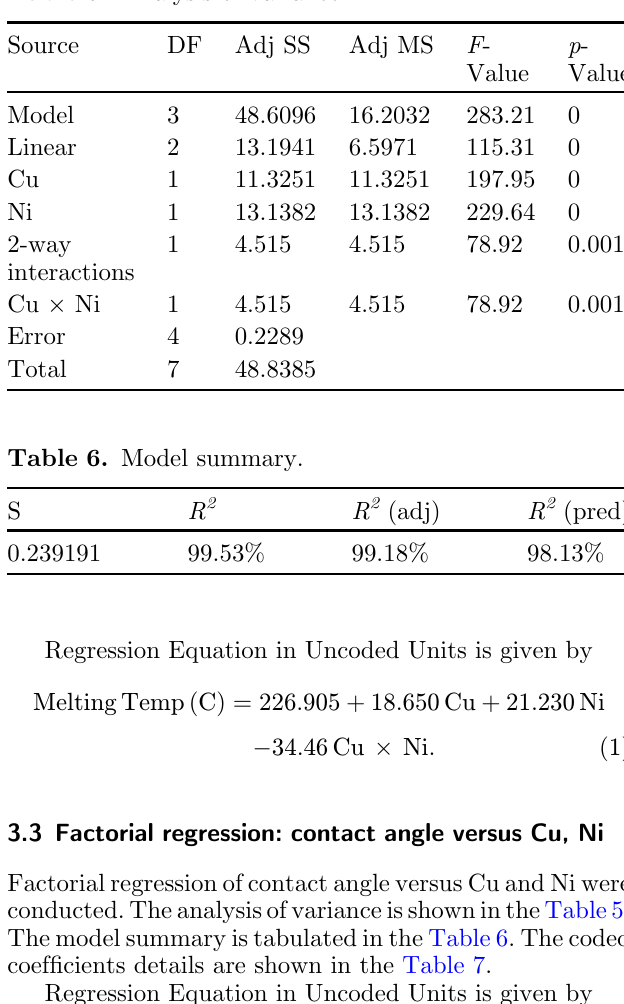
Table 5. Analysis of variance.